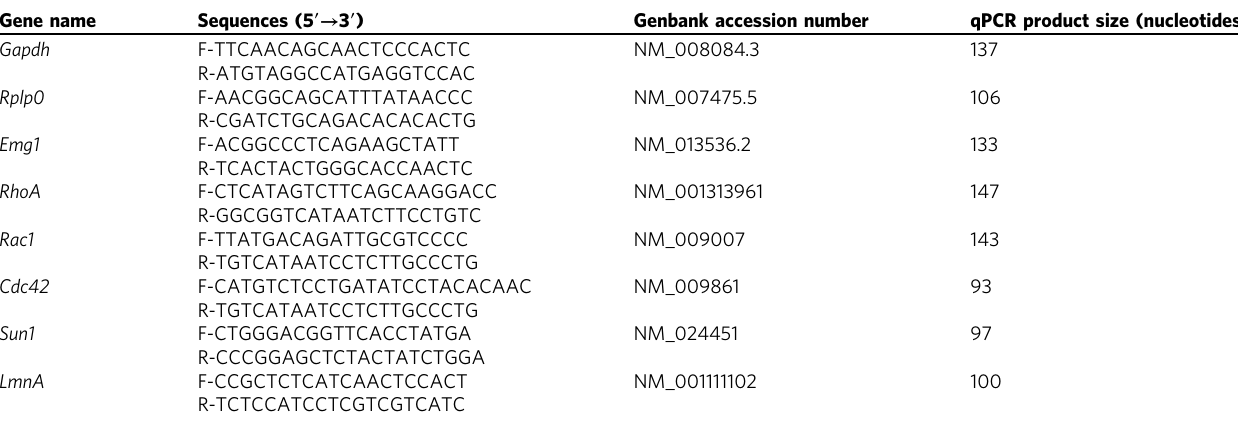
Table 2 Nucleotide sequences of primers used for quantitative qPCR detection. “ F ” indicates the forward primer and “ R ” the reverse primer. Gapdh , rplp0 , and Emg1 were used for